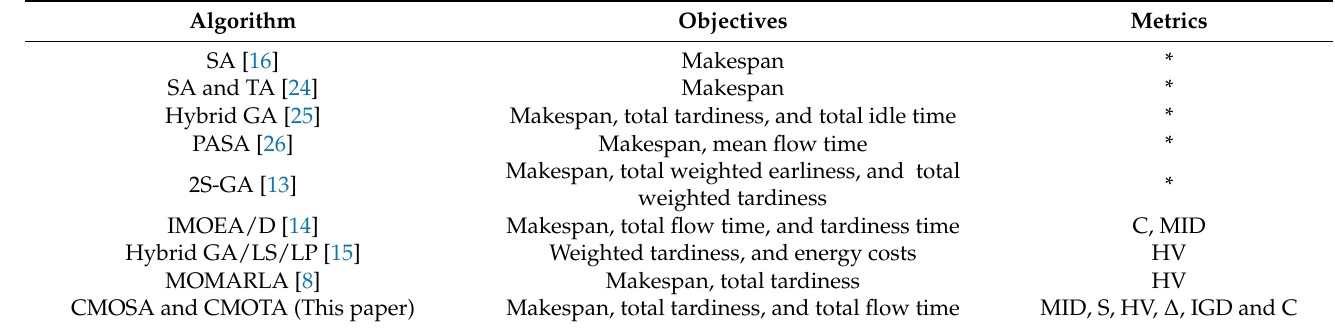
Table 1. Related